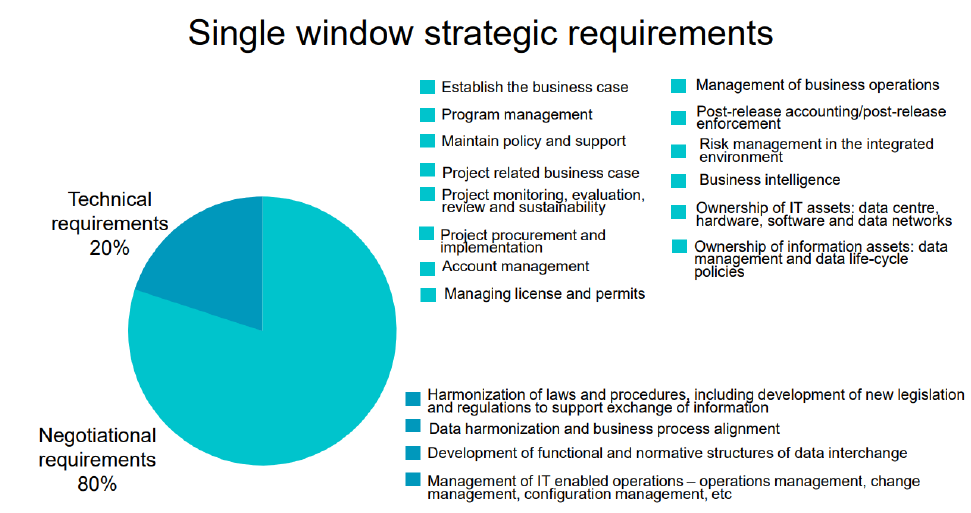
Figure 2. Actors’ strategic requirements analysis for a single-window system elaborated by the